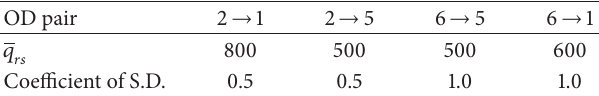
Table 1: Potential OD demands in the